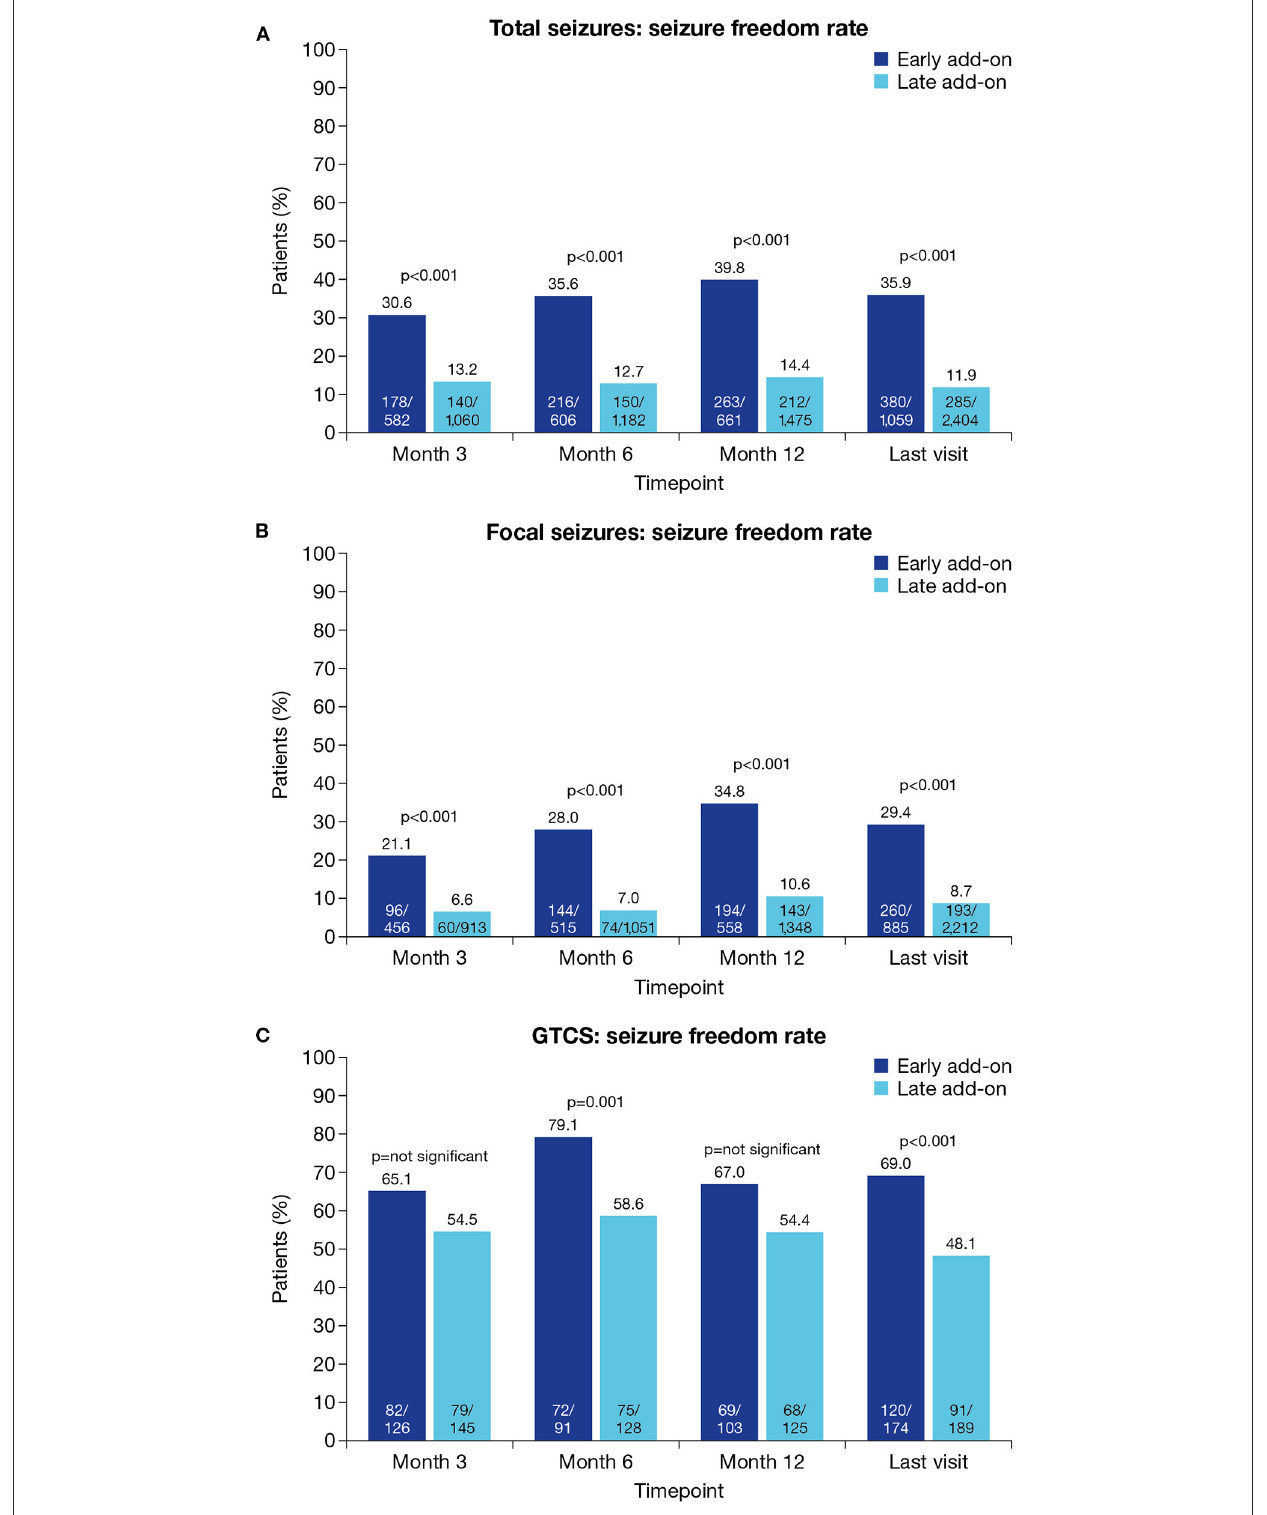
FIGURE4 Seizure freedom rates at Month 3, Month 6, Month 12 and the last visit in the early and late add-on subgroups for (A) total seizures, (B) focal seizures and (C) GTCS (effectiveness population). Seizure freedom was defined as no seizures since at least the prior visit. GTCS, generalized tonic-clonic